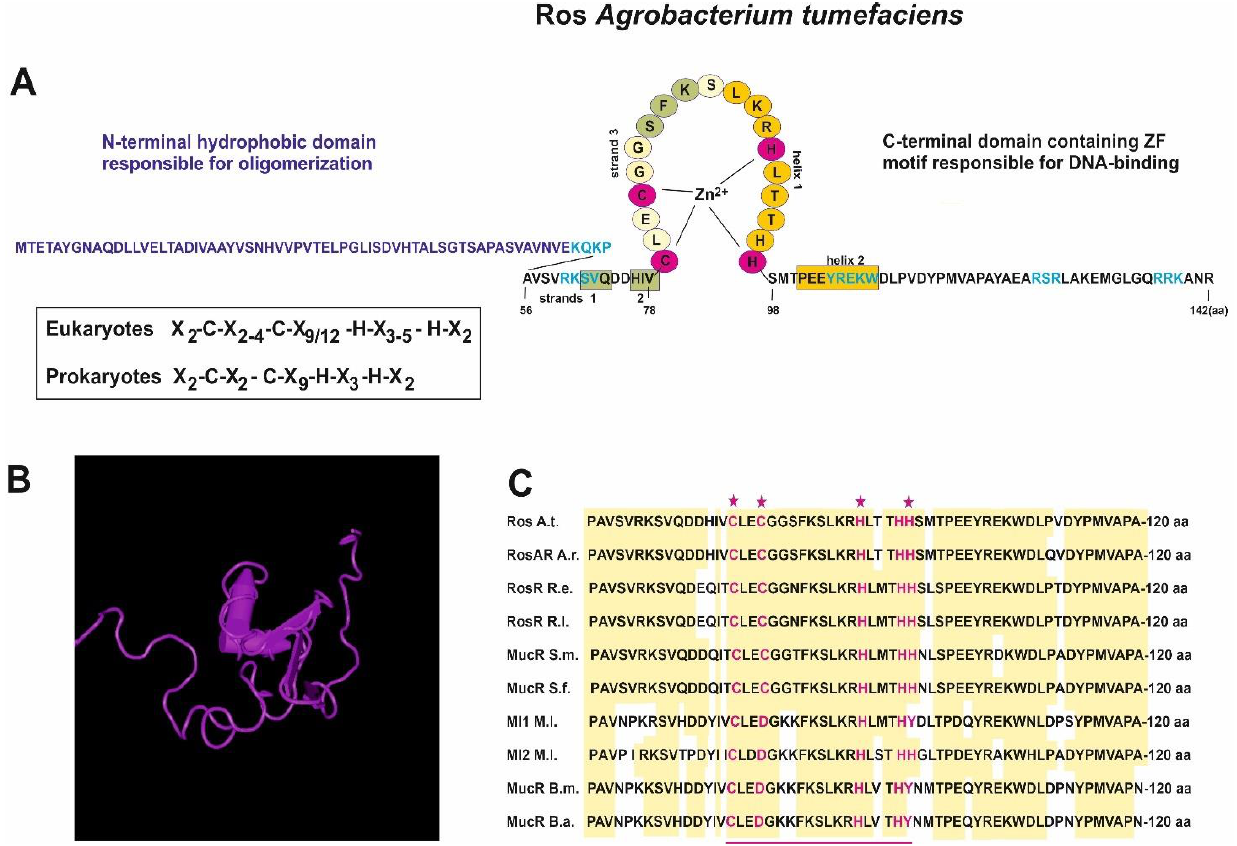
Figure 1. ( A ) Schematic representation of the amino acid sequence of A. tumefaciens Ros, including C 2 H 2 ZF motif. Amino acids engaged in binding of Zn 2+ ion, forming α -helixes and β -strands are marked in purple, orange, and green, respectively. Amino acids located in hydrophobic regions of Ros are marked in blue color. ( B ) Three-dimensional structure of Ros (PDB database, 2JSP); ( C ) Comparison of C 2 H 2 ZF motif sequences of different MucR/Ros representatives. Cysteines and histidines involved in Zn 2+ binding are marked in purple asterixes, and identical amino acids are shadowed in light yellow, respectively. Abbreviations: A.t. — Agrobacterium tumefaciens ; A.r. — Agrobacte-